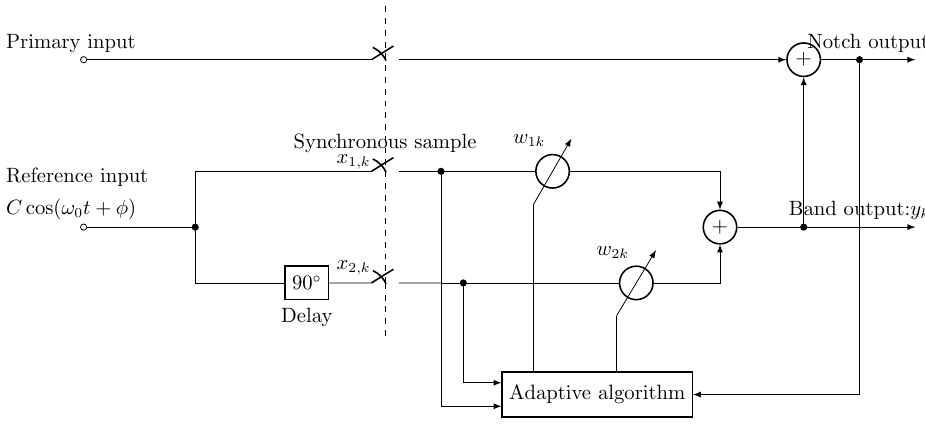
Figure 7. Structure of the adaptive